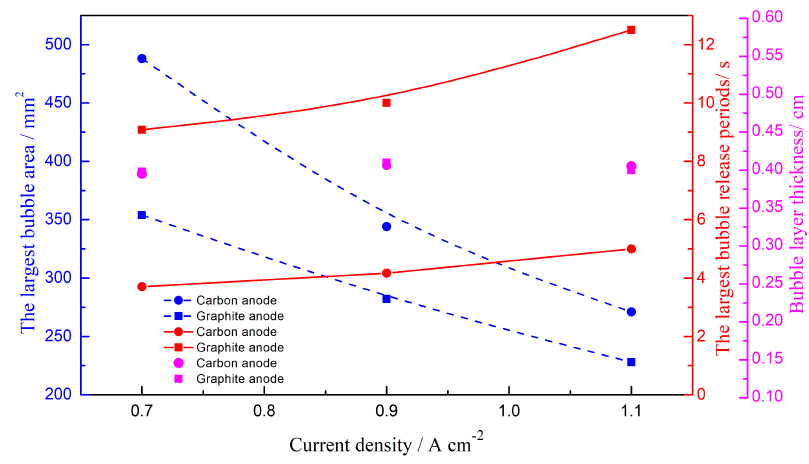
Figure 8. The largest bubble area, the release periods and bubble thickness as a function of anodic current density for the carbon and graphite anodes.